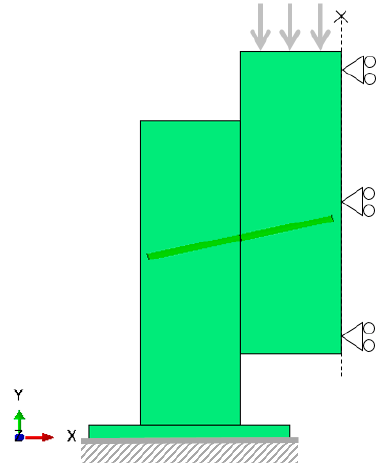
Figure 4. Reference FE numerical model for TTC joints with inclined STSs under a standard PO setup (S#1, α = − 15°).